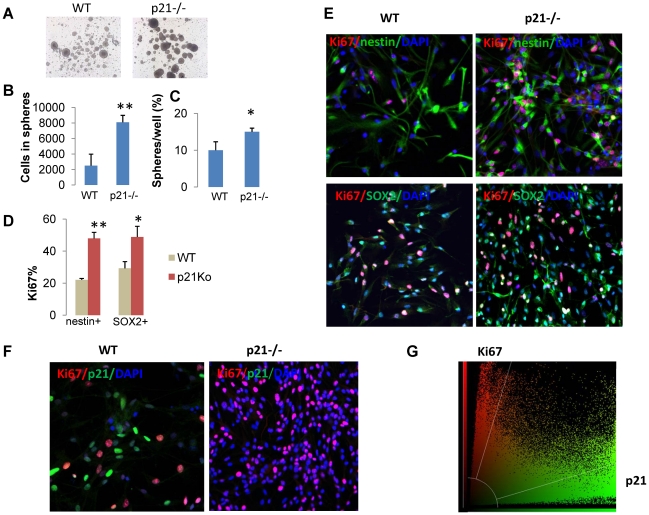
Increased proliferation of NPC derived from p21-/- mice.
A) The spheres derived from WT and p21-/- hippocampi 7 days after plating. Note bigger size and more cellularity in p21-/- spheres; B) Seven days after seeding, the NPC spheres were collected, dispersed and the number of cells was counted; C) Sphere self-renewal analysis. NPC spheres were dispersed and cells were seeded at 0.5 cell/well into 96-well plates. The percent of cells forming new spheres was determined after 10 days; D) The percent of Ki67-positive cells co-expressing nestin or SOX2. Counting was performed in triplicate (>500 cells per sample). Data are presented as a mean ± SEM, *, p<0.05, **, p<0.01; E) Representative confocal images of proliferating NPC derived from WT and p21-/- hippocampi and stained for Ki67 (intranucelar, red) and nestin (cytoplasmic, green) or SOX2 (intranuclear, green). p21-/- NPC exhibit more Ki67-positive cells; F) Proliferating neuronal precursors derived from WT and p21-/- hippocampi and stained for Ki67 (intranucelar, red) and p21 (intranuclear, green). Note that WT NPC cells positive for Ki67 are negative for p21; G) Double-labeling analysis of WT NPC with a color-coded fluorogram. The confocal image shows the absence of co-localization between p21 (green) and Ki67 (red).